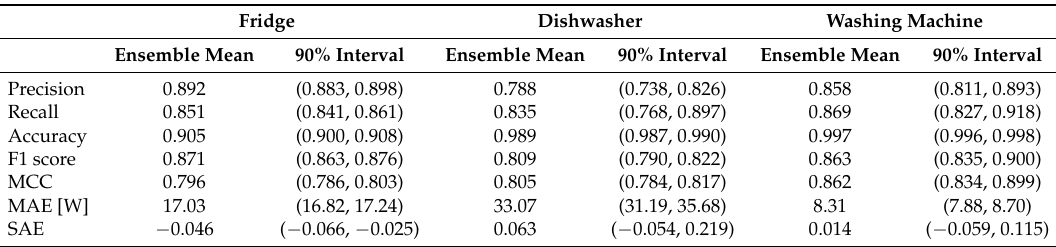
Table 5. Performance of the method for the unseen case for house 2 of the UK-DALE dataset. In total, 20 different instances of the neural network have been trained and the value of the ensemble estimate and the 90% range of performance variation are